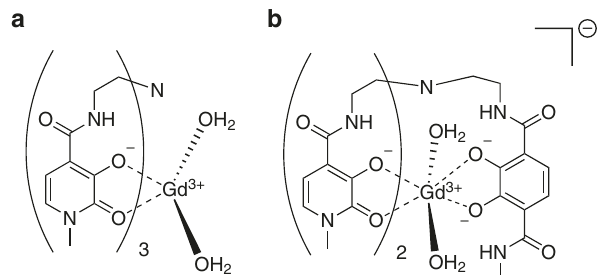
Fig. 6 Exemplar chemical structures of Gd(III) complexes of the acyclic “ hopo ” ligands. Charged oxygen donors are a feature within the ligands: H tren-Me-3,2-hopo (complex a ) and H 3 -tren-Me-3,2-hopotam (complex b ). Enhanced stability is observed due to the signi fi cant oxophilicity of the Gd (III)